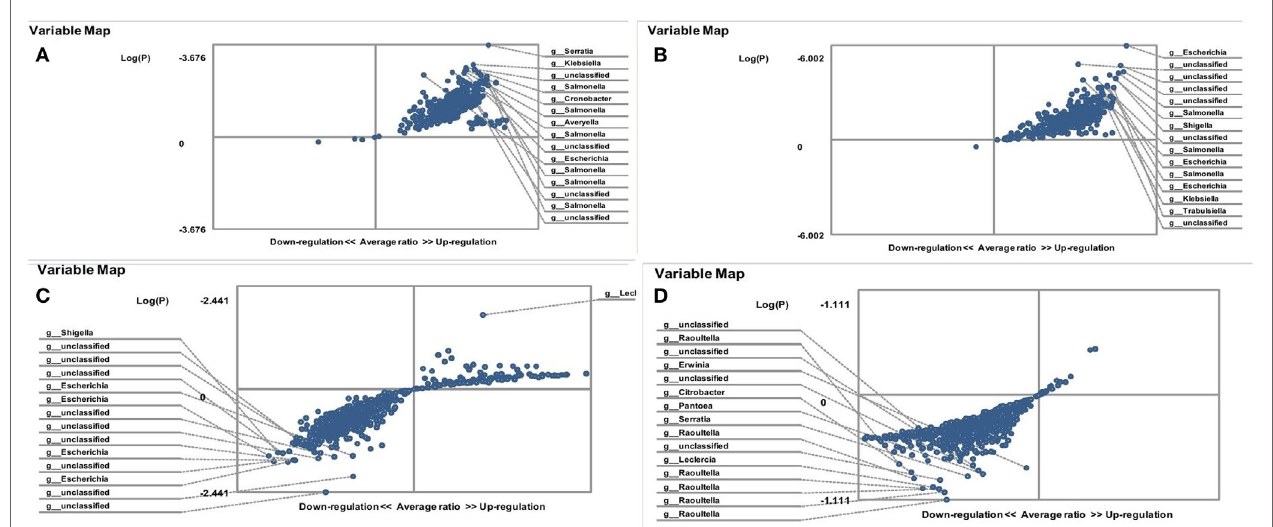
FigUre 1 | Distribution of gut Enterobacteriaceae in Candida albicans -carrier familial Mediterranean fever (FMF) patients. Contribution of variables to differentiation between two groups [ X axis, average ratio between two groups; Y axis, − Log (P)]. The upper-right and lower-left corner are the most significant. (a) FMF women with gut C. albicans numbers above baseline level/FMF men with gut C. albicans numbers above baseline level; (b) FMF women with gut C. albicans numbers above baseline level before probiotic therapy/Healthy women; (c) FMF women with gut C. albicans numbers above baseline level after probiotic therapy/FMF women with gut C. albicans numbers above baseline level before probiotic therapy; (D) FMF men with gut C. albicans numbers above baseline level/Healthy